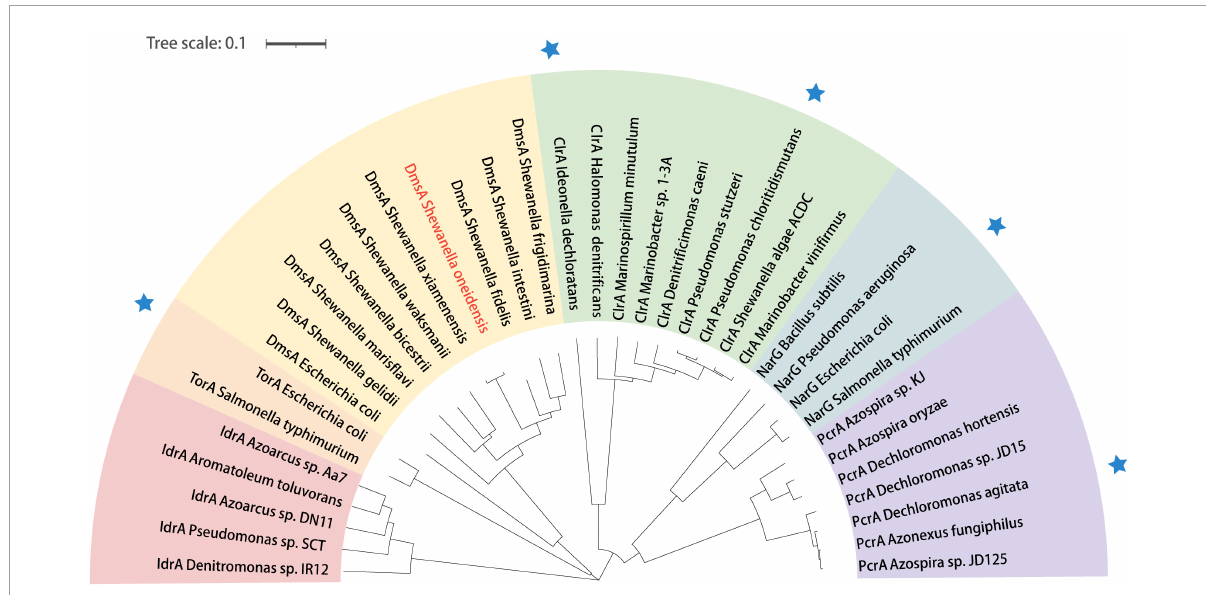
FIGURE4 Phylogenetic analysis of DmsA of Shewanella species in relation to other reductases in the DMSO reductase family. The phylogenetic tree is constructed using the neighbor-joining method, and the bootstrap values of all nodes in the tree are not less than 50%. Blue star indicates that the protein has exhibited bromate-reducing activity in vitro . IdrA, iodate reductase; TorA, trimethylamine-oxide reductase; DmsA, DMSO reductase; ClrA, chlorate reductase; PcrA, perchlorate